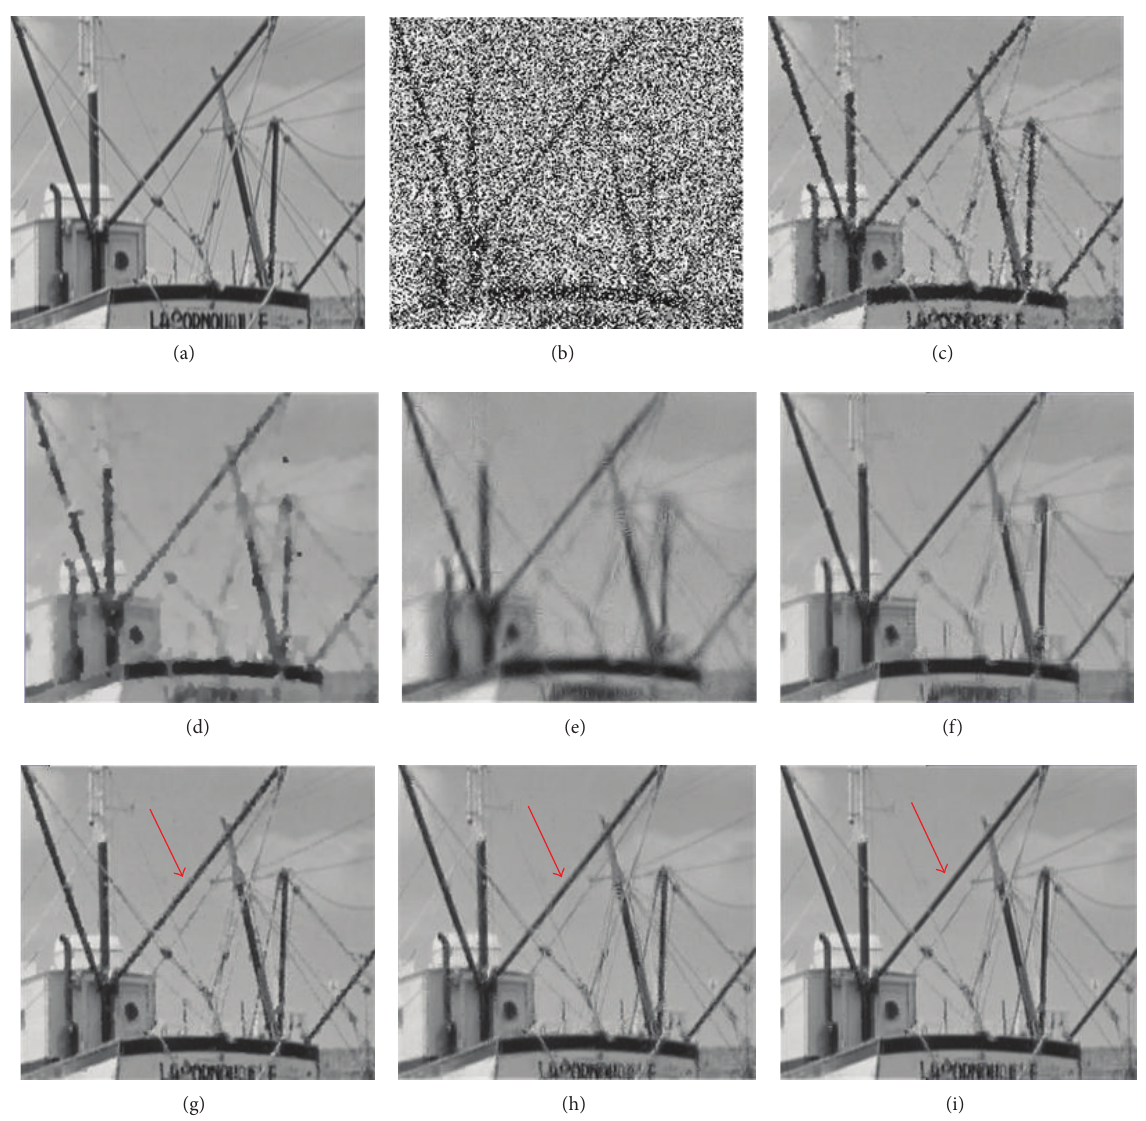
Figure 6: Reconstructed Boat images from 50% salt and pepper impulse noise. (a) Noise-free image, (b) noisy image, (c)–(i) reconstructed images using AMF, TV, Wavelet, PANO, TV-ND, Wavelet-ND, and PANO-ND, respectively.